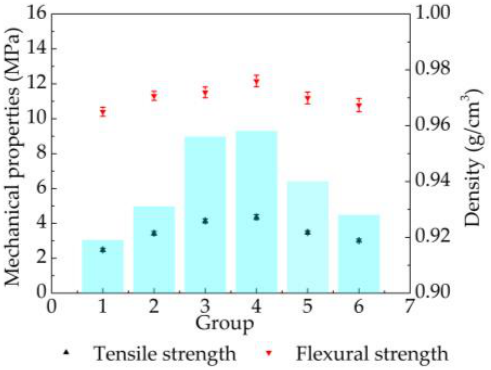
Figure 5. Mechanical properties and density of laser-sintered 10%-CPLA parts under different thermal post-processing (1, the green part; 2, 65 °C; 3, 100 °C; 4, 110 °C; 5, 120 °C; 6, 130 °C).